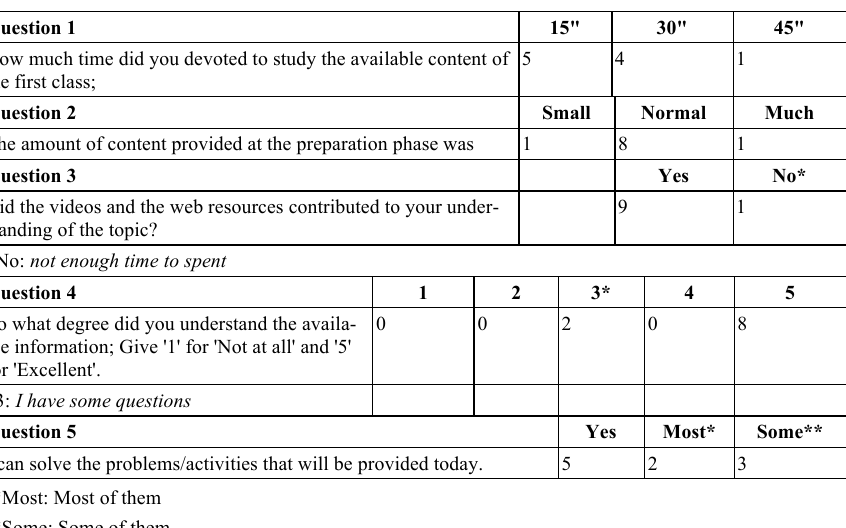
Table 1. Students’ answers to the pre-class